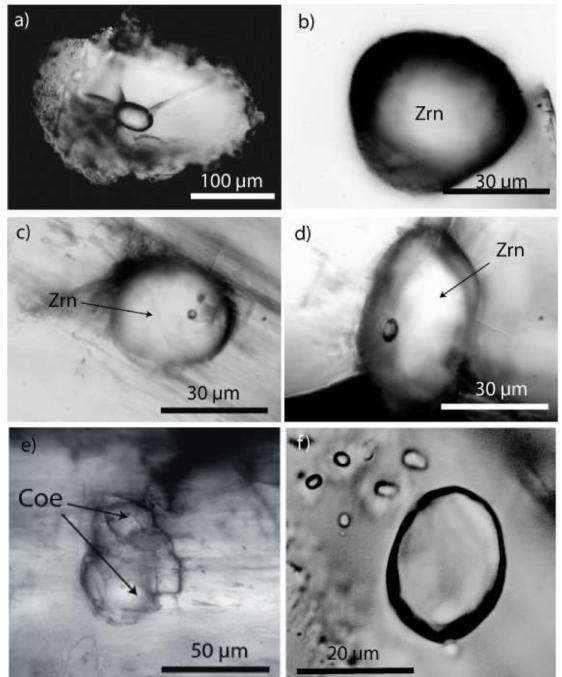
Figure 8. Examples of spherical crystals in different minerals from the Waldheim granulite: ( a ) zircon inclusion in the center of an elliptical high-quartz crystal. The quartz host displays radial fractures due to the volume expansion of the primary reidite-to-zircon transition [27]. ( b – d ) spherical zircon crystals in prismatine. ( e ) a conglomerate of coesite ellipsoids in prismatine. There is a thin layer of muscovite and clinochlore between the coesite and the prismatine host. ( f ) spherical anorthite crystals in an ellipsoidal corundum